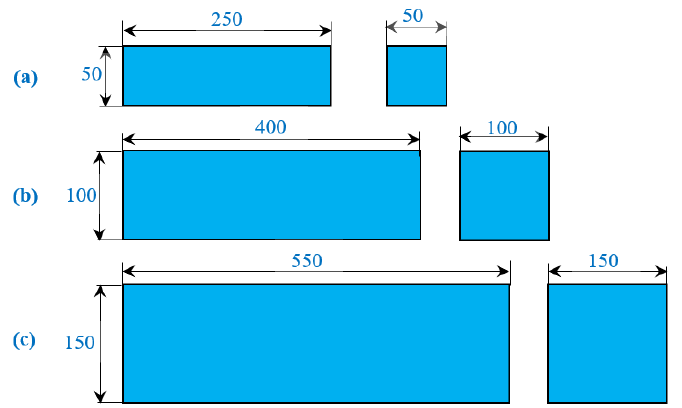
Figure 3. Three different beam geometries used in this research. ( a ) Small beam; ( b ) Medium beam; ( c ) Large beam.